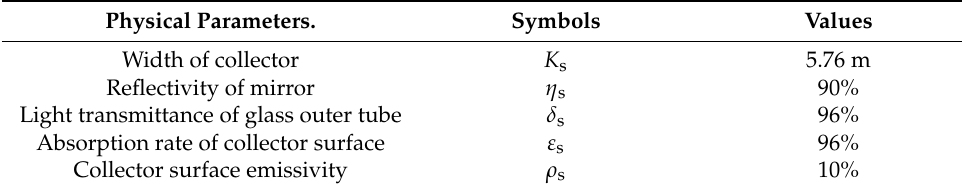
Table 1. Parameters of the LS-3 solar collector. Physical Parameters. Symbols Values Width of collector K s 5.76 m Reflectivity of mirror η s 90% Light transmittance of glass outer tube δ s 96% Absorption rate of collector surface ε s 96% Collector surface emissivity ρ s